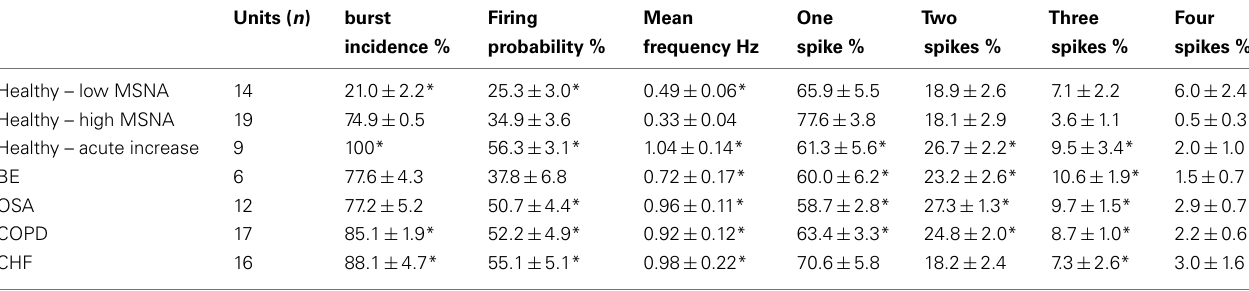
Table 2 | Firing properties (mean ± SE) of muscle vasoconstrictor neurons in healthy subjects with low (Macefield et al., 1994) or high (Macefield andWallin, 1999) resting levels of MSNA, during an acute increase in MSNA caused by a maximal inspiratory breath-hold (Macefield andWallin, 1999), and in patients with bronchiectasis (BE;Ashley et al., 2010), obstructive sleep apnea (OSA; Elam et al., 2002), chronic obstructive pulmonary disease (COPD;Ashley et al., 2010), or congestive heart failure (CHF; Macefield et al.,